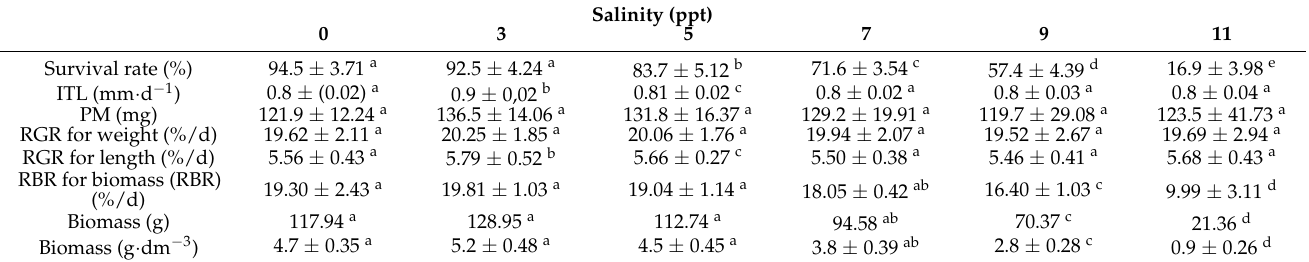
Table 1. Selected final parameters of asp larvae Leuciscus aspius (L.) rearing (mean ± SD): survival rate, increases in total length—ITL (mm · d − 1 ), increases in average weight PM, larvae biomass (g · dm − 3 ) are shown in parentheses ( ± ).